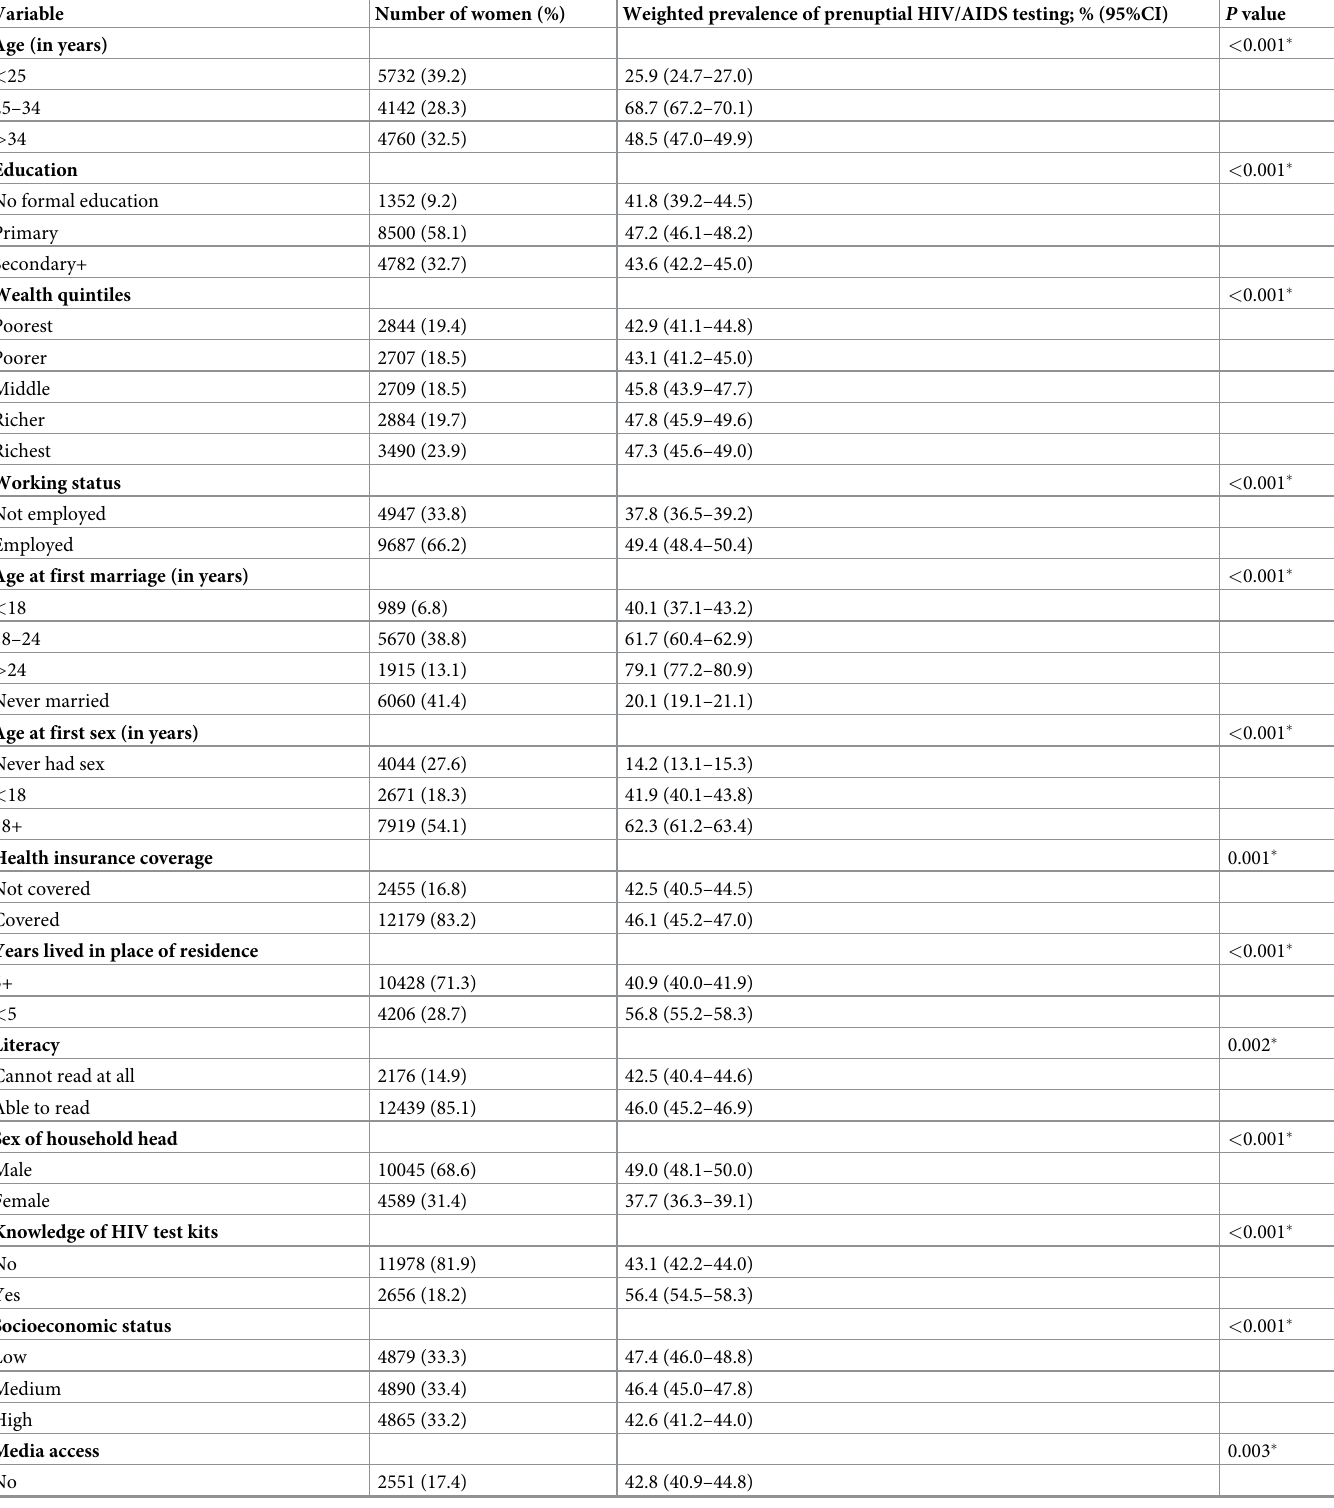
Table 1. Prevalence of prenuptial HIV/AIDS testing across women’s characteristics (n =